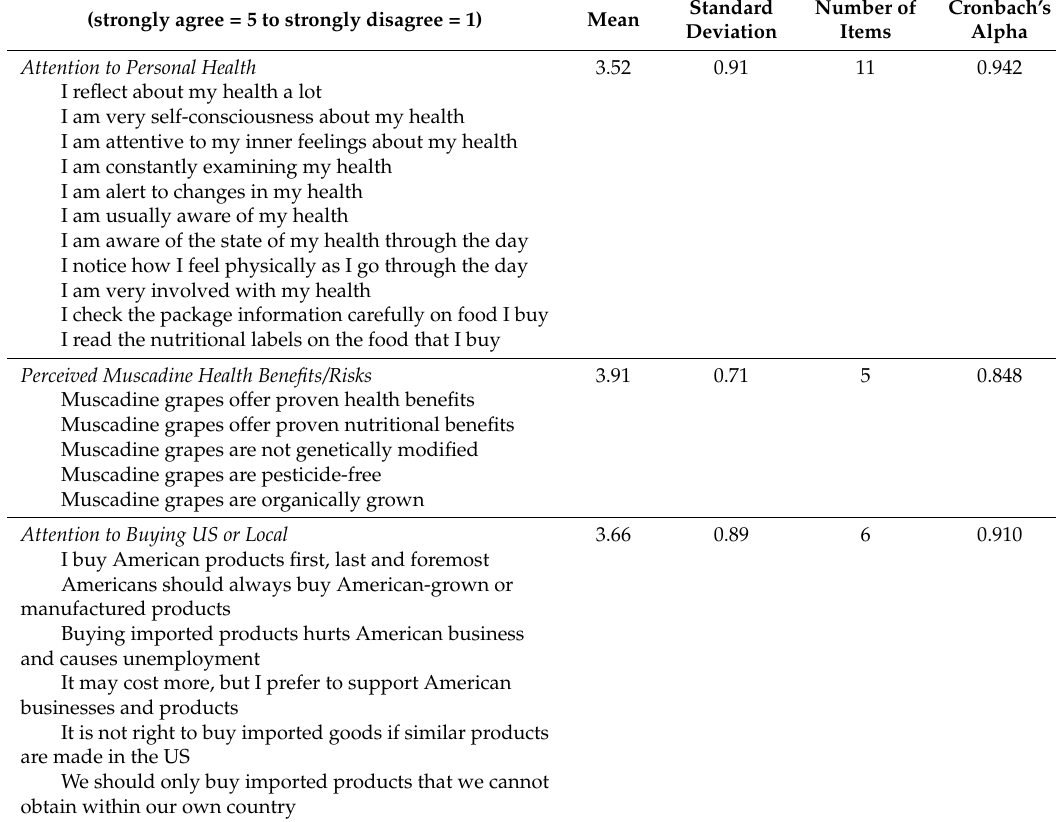
Table 2. Supplemental marketing